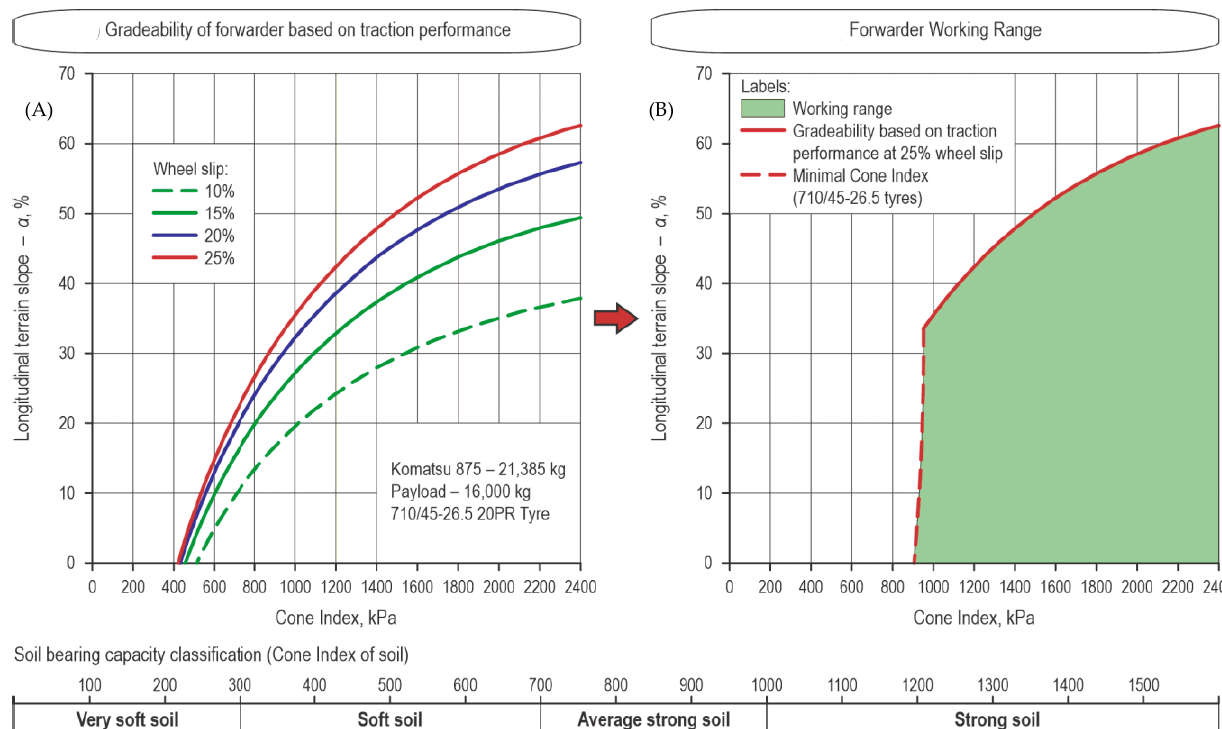
Figure 7. Gradeability ( A ) and working range ( B ) of Komatsu 875 forwarder[42].